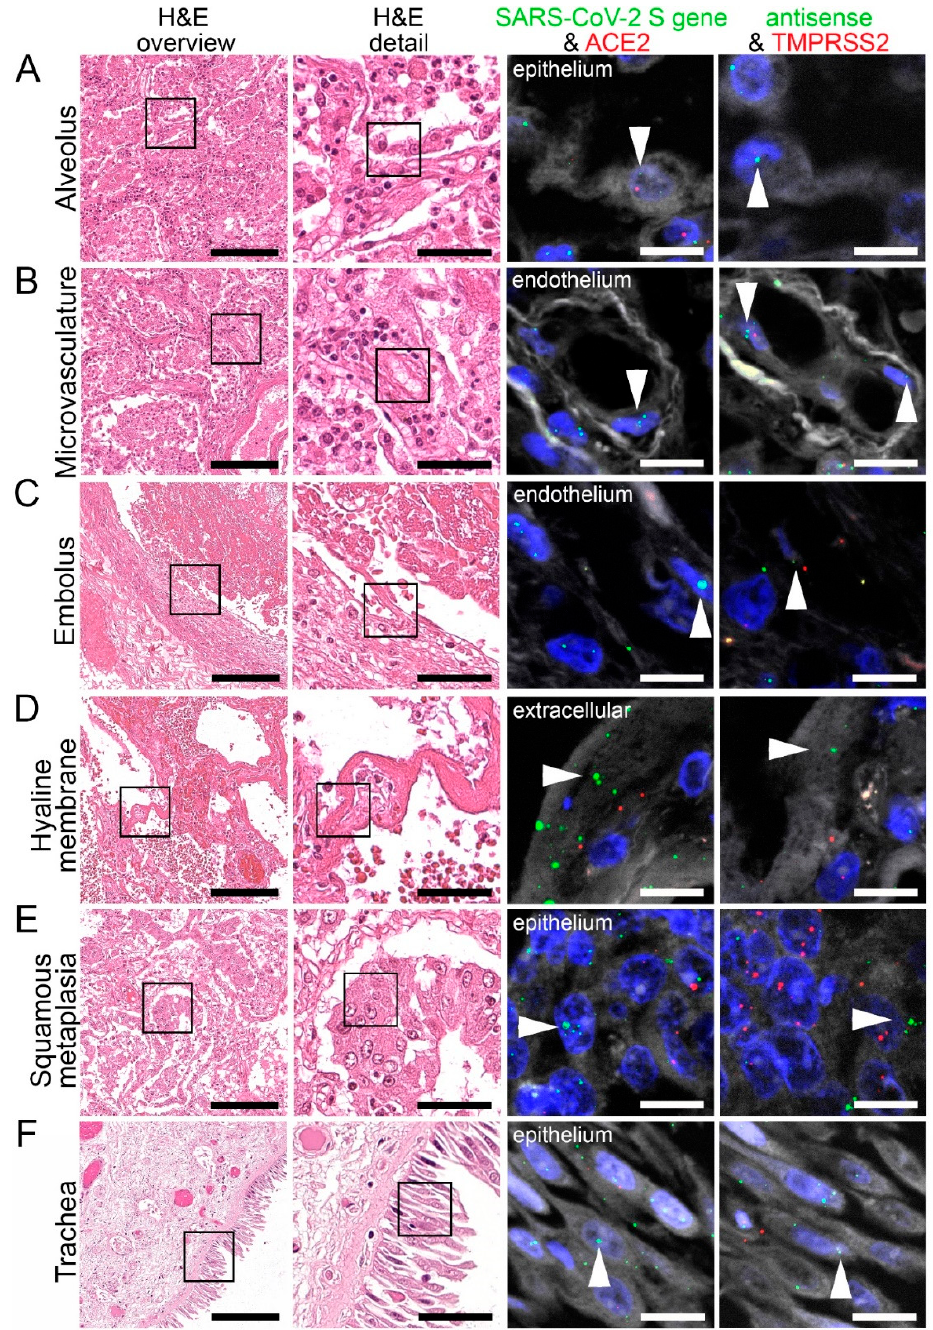
Figure 4. Virus detection in the respiratory system by FISH. HE stained lung tissue and representative image sections showing FISH co-visualization of RNA sequences either of SARS-CoV-2 S gene genomic RNA (green, arrowhead) and ACE2 (red) or SARS-CoV-2 antisense strand RNA as an indicator of replicating virus (green, arrowhead) and TMPRSS2 (red). Morphological details are shown in regions of the alveolus ( A , alveolar pneumocytes), endothelium in the alveolar wall ( B ), endothelial cells adjacent to an embolus ( C ), hyaline membrane ( D ), squamous metaplasia ( E , metaplastic epithelium), and trachea ( F , respiratory epithelium). Scale bars represent 200, 50 and 10 µm, respectively.